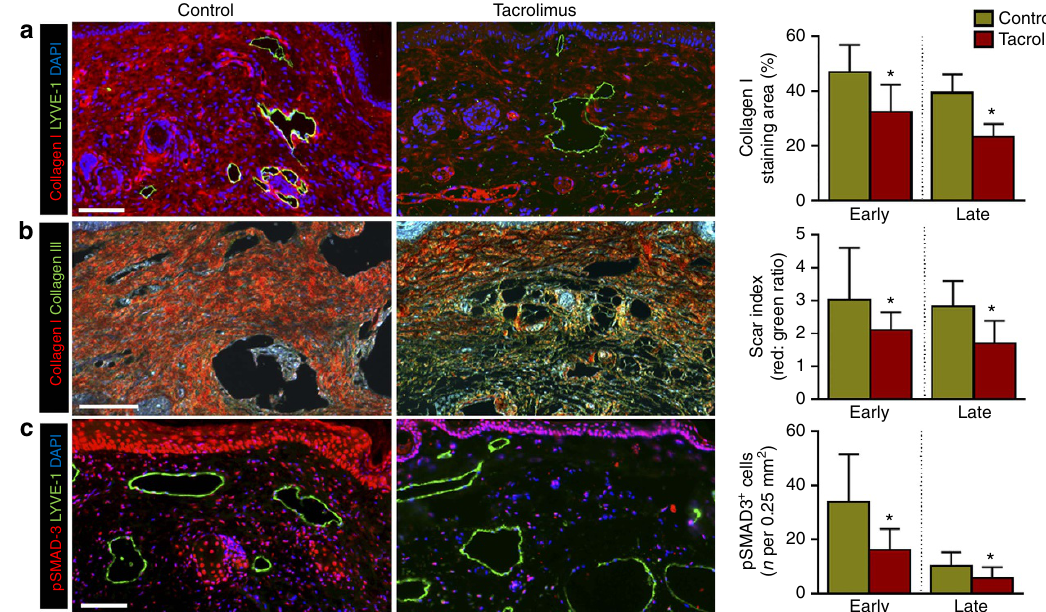
Figure 3 | Topical tacrolimus decreases fibrosis in lymphedema. ( a ) Representative (cid:3) 40 images of tail tissues from control or early tacrolimus-treated mice 6 weeks after surgery with immunofluorescent localization of type I collagen (red) and lymphatic vessels (green). Quantifications of the percent area of collagen I staining in both early and late treatment are shown to the right ( P o 0.001 for both; n ¼ 8/group). ( b ) Representative (cid:3) 40 images of picrosirius red staining of tail tissues harvested from control or early tacrolimus-treated animals (red-orange birefringence represents collagen I deposition; green-yellow birefringence represents collagen III deposition). Quantification of Scar Index (red: green ratio) is shown to the right ( P ¼ 0.036 early; P o 0.001 late; n ¼ 8/group). ( c ) Representative (cid:3) 40 immunofluorescent co-localization of pSMAD-3 (red) with lymphatic vessel (green) in tail tissues harvested from animals treated with control or early treatment with tacrolimus 6 weeks after surgery. Quantification of the number of positive cells per 0.25mm 2 area (four random areas per mouse) for both is shown to the right of ( P ¼ 0.002 early, P ¼ 0.026 late; n ¼ 8/group). Experiments were repeated two to three times. All data represent mean ± s.d. with P r 0.05 considered as significant. Data analysed by two-tailed Student’s t -test. Scale bars, 100 m